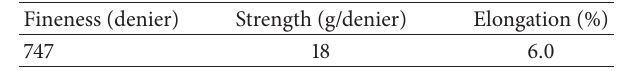
Table 2: Properties of polyketone fiber used in this study.